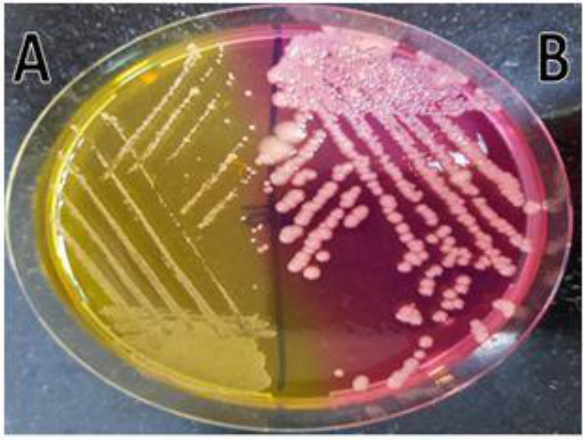
Fig.2 : A: Non-lactose fermenter on MacConkey agar, Table 3: Prevalence of Acinetobacter species isolates from the examined samples